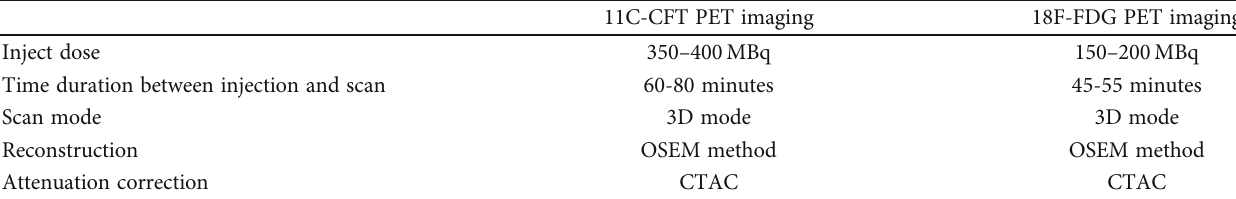
Table 2: Acquisition protocols of PET imaging.